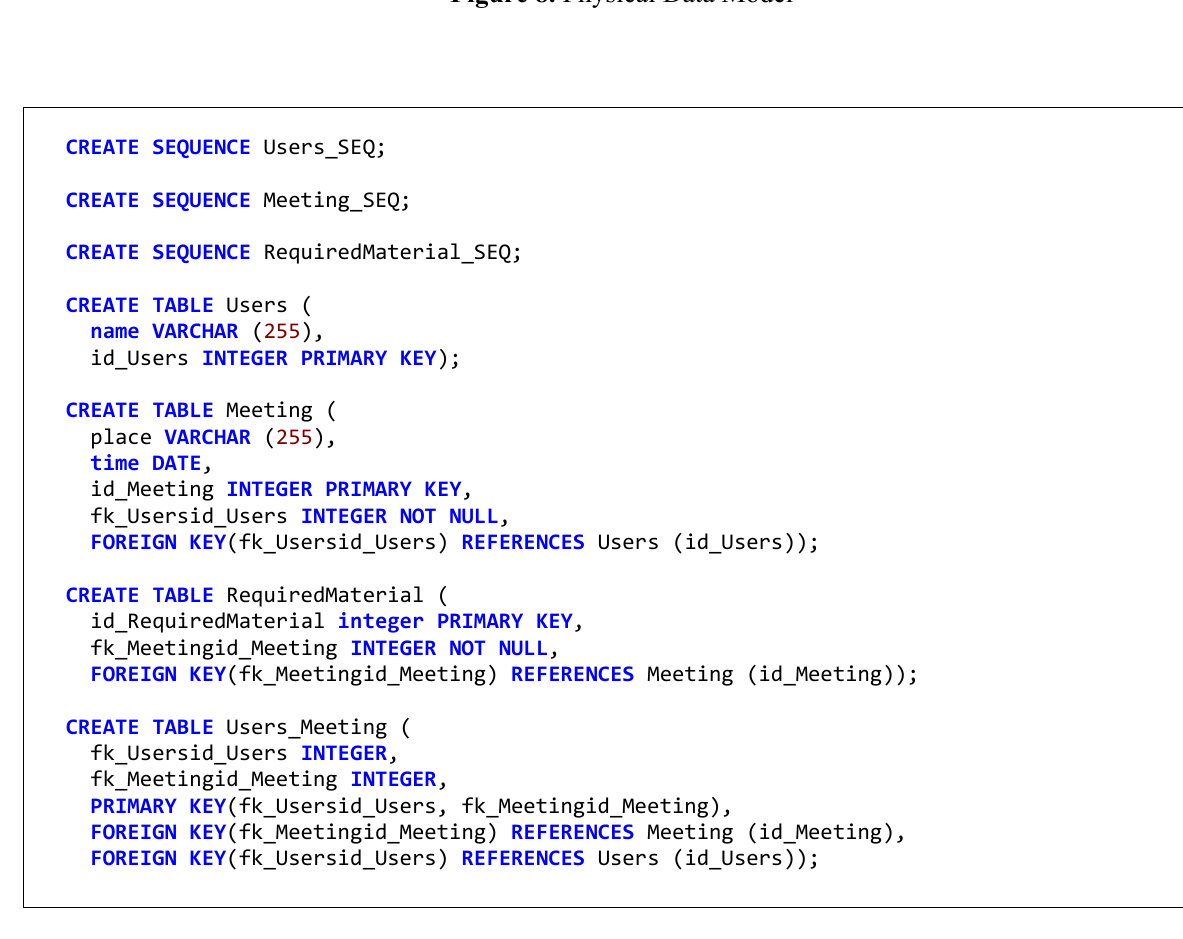
Figure 9. Database SQL data definition